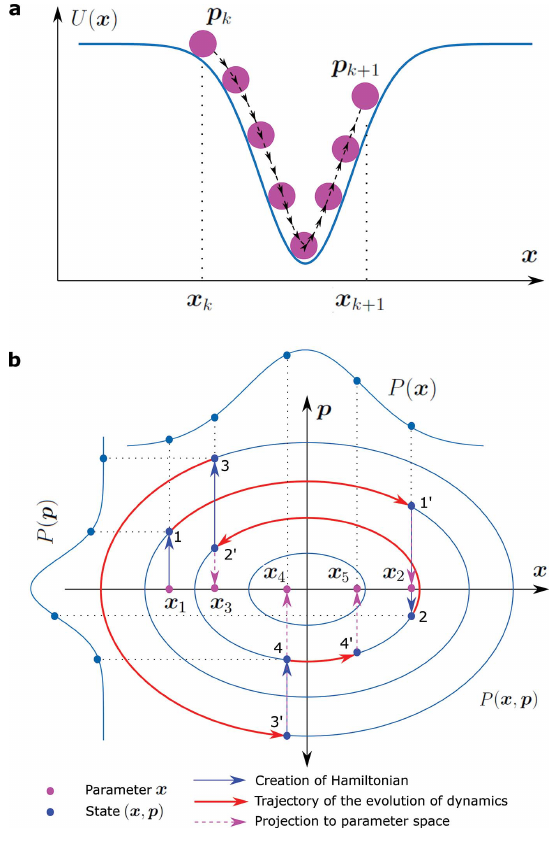
Figure 1 ( a ) Illustration of the evolution of Hamiltonian dynamics to move an object from x to x in the parameter space. Flipping the direction of k k þ 1 the momentum p at x reverses the energy and brings the object k þ 1 k þ 1 back to x . ( b ) An HMCMC drawing sequence. Contour lines are the k joint probability distribution P ð x ; p Þ . The topmost and leftmost curves represent the marginal distributions of the parameter and the momentum, respectively. With an initial parameter x , a random 1 Þ of Hamiltonian ; p momentum is generated to create a state ð x 1 1 Þ (blue arrow). Parameter x ; p H ð x is generated as the result of the 1 1 2 Þ to state ð x Þ through the trajectory 1 ! 1 0 ; p ; p evolution from state ð x 1 1 2 2 (red arrow). This process repeats to generate a sequence of